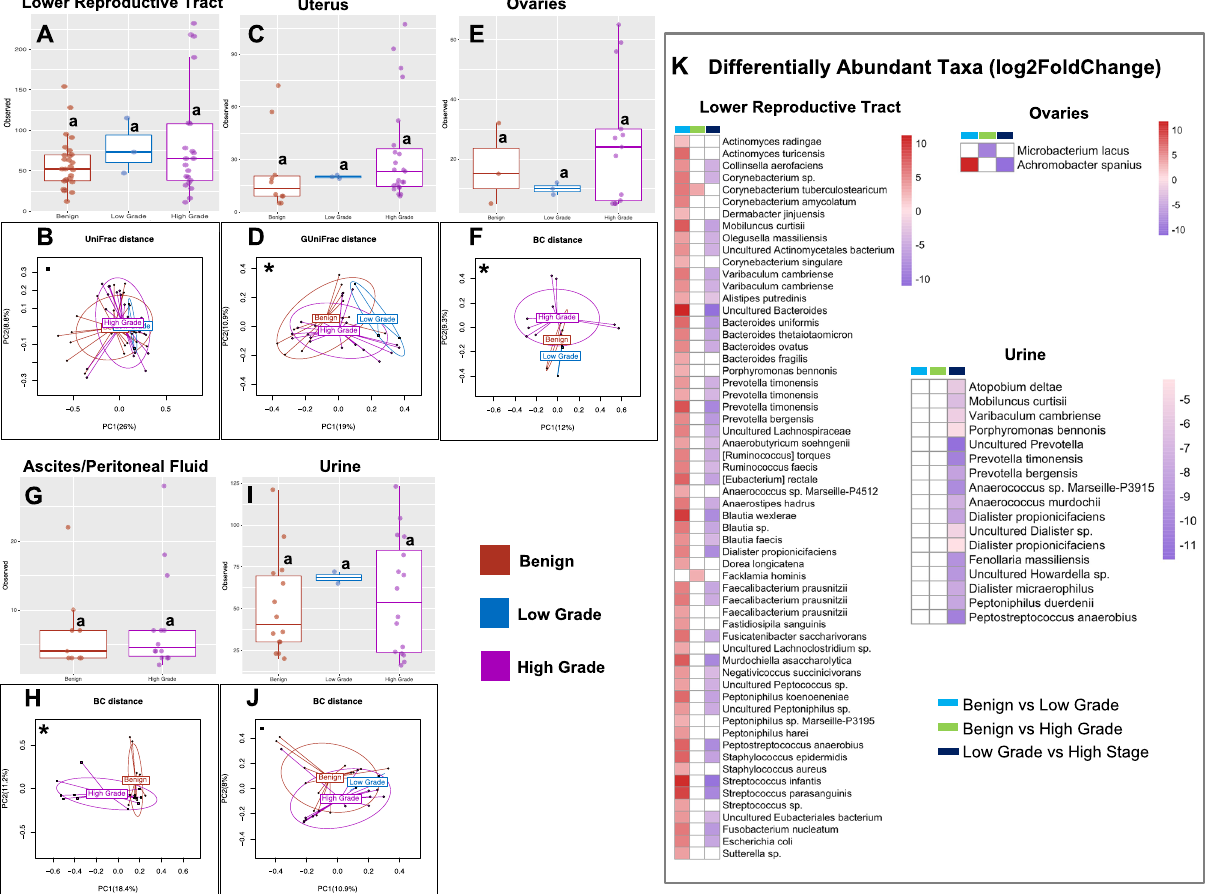
Figure 4. Bacterial community α- and β-diversity among patients with and without different grades of OC (OC). Both α- and β-diversities measures were compared. For α-diversity a Wald statistical test was performed and Observed ASVs was reported. For β-diversity, Bray–Curtis (BC), unweighted, and generalized UniFrac distance metrics were reported. The most significant metric is shown in each ordination plot. Lower reproductive tract (cervix and vagina), ( A ) α-diversity: Benign vs Low grade ( p = 0.221), High grade ( p = 0.997), ( B ) β-diversity: Benign vs Low grade ( p = 0.195), High grade ( p = 0.087), Low grade vs High grade ( p = 0.406). Uterus, ( C ) α-diversity: Benign vs Low grade ( p = 0.400), High grade ( p = 0.159), ( D ) β-diversity: Benign vs Low grade ( p = 0.023), High grade ( p = 0.014), Low grade vs High grade ( p = 0.019). Ovaries, ( E ) α-diversity: Benign vs Low grade ( p = 0.972), High grade ( p = 0.552), ( F ) β-diversity: Benign vs Low grade ( p = 0.350), High grade ( p = 0.067), Low grade vs High grade ( p = 0.045). Ascites/Peritoneal fluid, ( G ) α-diversity: Benign vs High grade ( p = 0.536), (H) β-diversity: Benign vs High grade ( p = 0.016). Urine, ( I ) α-diversity: Benign vs Low grade ( p = 0.490), High grade ( p = 0.534), ( J ) β-diversity: Benign vs Low grade ( p = 0.615), High grade ( p = 0.056), Low grade vs High grade ( p = 0.717). ( K ) Heatmaps showing the effect size (Log 2 Fold Change) of the differentially abundant microbial taxa. White boxes reflect no fold change at FDR < 0.10. Analysis was adjusted for menopause status, and BMI. Samples rarefied prior to analysis. Wald statistical test with Q value cutoff = 0.1. *Groups are significantly